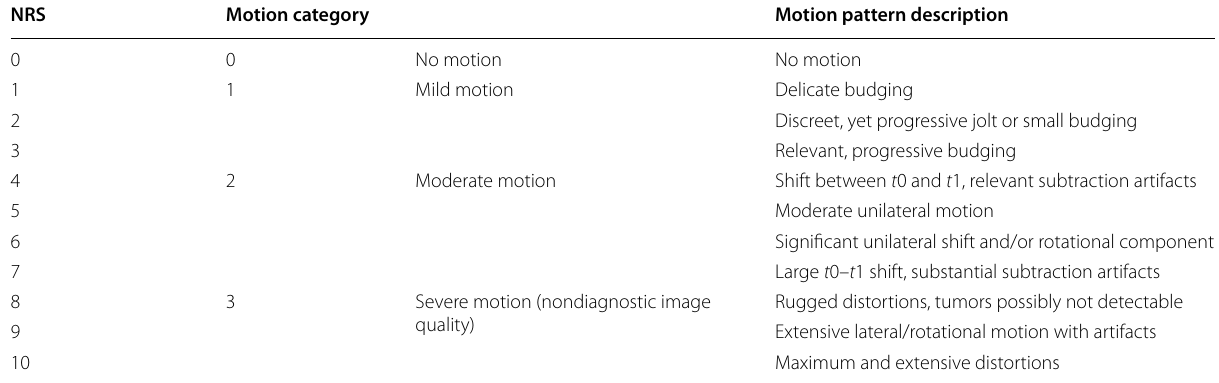
Intrasequence motion was assessed on a numerical ranking scale and assigned to one of four motion categories. Use of this ranking scale ensures quantifiability and reproducibility of subjective assessment of motion, both before and after registration. Steps on the NRS are described by typical examples of respective motion patterns. t 0– t 1 shift refers to disproportionately strong motion between the unenhanced time point [ t 0] and the first postcontrast time point [ t